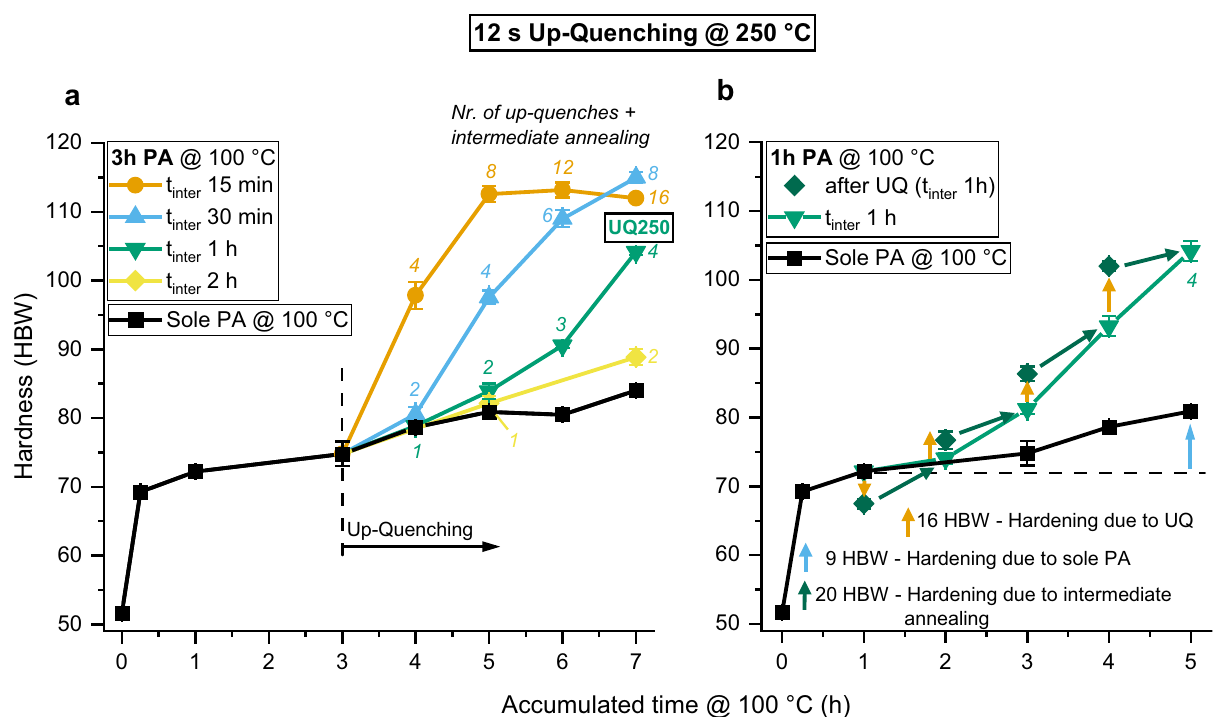
Fig. 4 Acceleration of hardening during annealing at 100 °C via up-quenching. a Pre-annealing (PA) (3 h; 100°C), up-quenching (12 s; 250 °C) and intermediate annealing (15 min to 2 h; 100 °C). Accumulated time stands for the total time at 100 °C (pre-annealing + t inter ). b Pre-annealing (PA) (1 h; 100 °C), up-quenching (12 s; 250 °C) and intermediate annealing (1 h; 100 °C). A gradual hardness evolution is shown in ( b ). The three numerical hardness values represent the total hardness increase triggered by the different treatments (illustrated by differently coloured arrows). Whereas hardness decreases due to up-quenching after 1 h, the second and every subsequent up-quenching cause a hardening increase (orange arrows, 16 HBW). Compared to just pre- annealing (blue arrow, 9 HBW), up-quenching causes hardening to double during the subsequent intermediate annealing steps at 100 °C (green arrows, 20 HBW). The error bars for each hardness measurement were determined from at least fi ve hardness indents and represent one standard